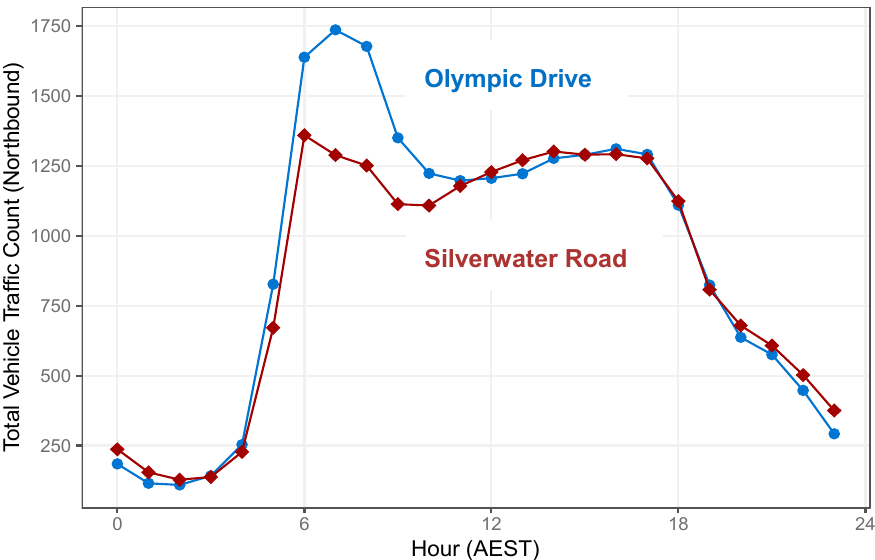
Figure 5. Hourly mean traffic counts (26 May 2016–13 September 2017) for Olympic Drive (blue circles) and Silverwater Road (red diamonds).